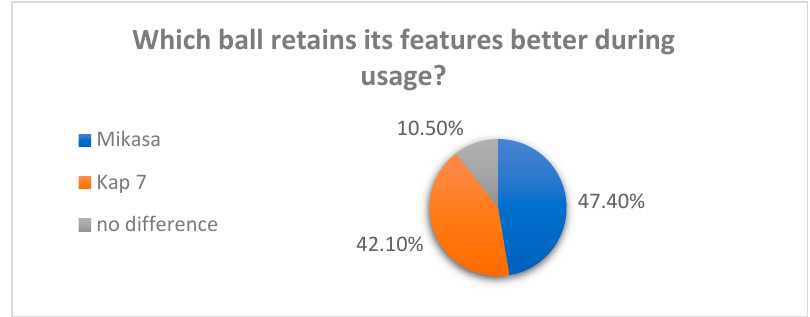
Figure 3. Usage “in time” assessment—survey results.